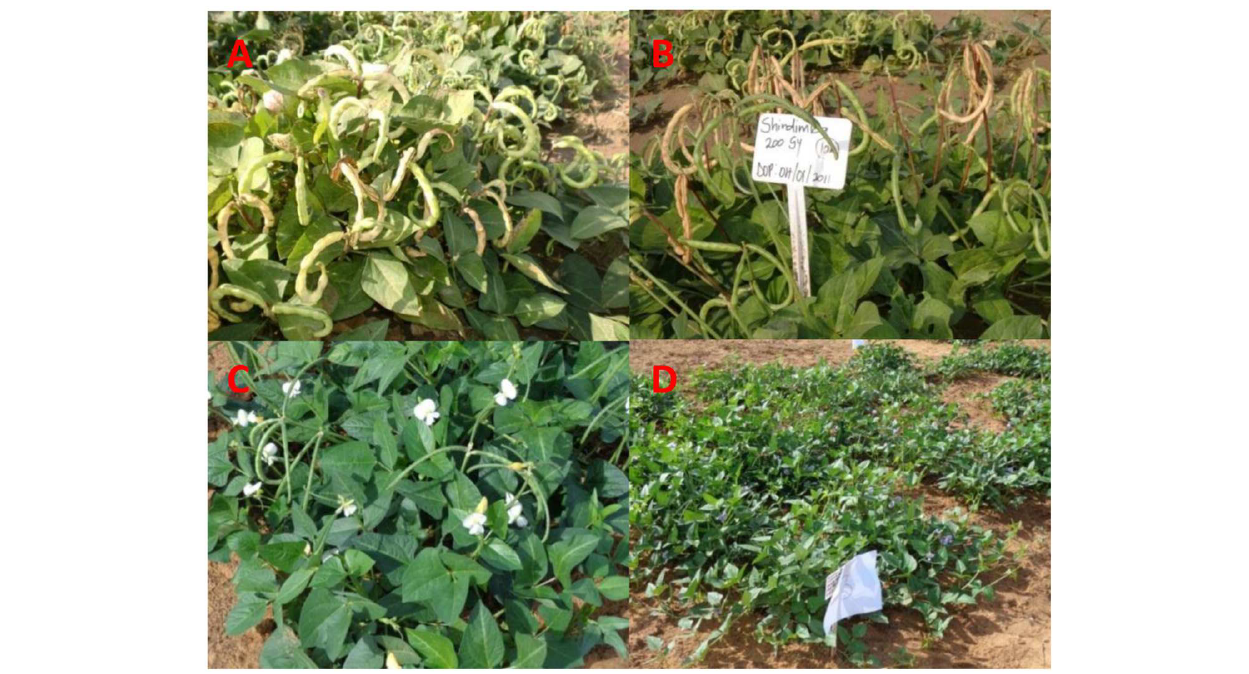
FIGURE 5 | Variation among Shindimba mutant lines. (A) coiled pods, (B) semi-coiled pods observed at Mannheim during the M 2 generation, (C) white flower with semi-coiled pods, and (D) Purple flowers observed at Omahenene during the M 5 generation.